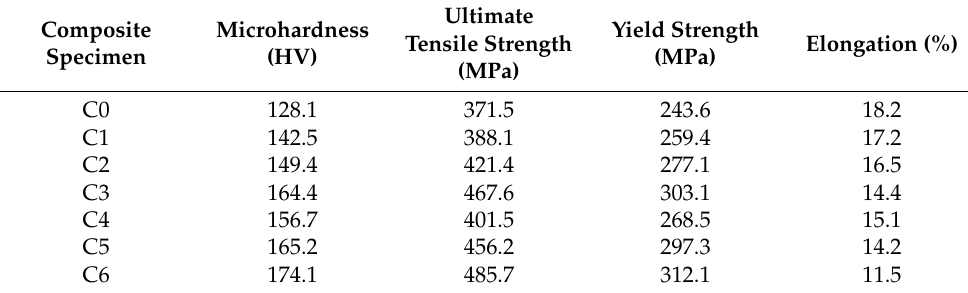
Table 4. Mechanical Properties of Copper hybrid